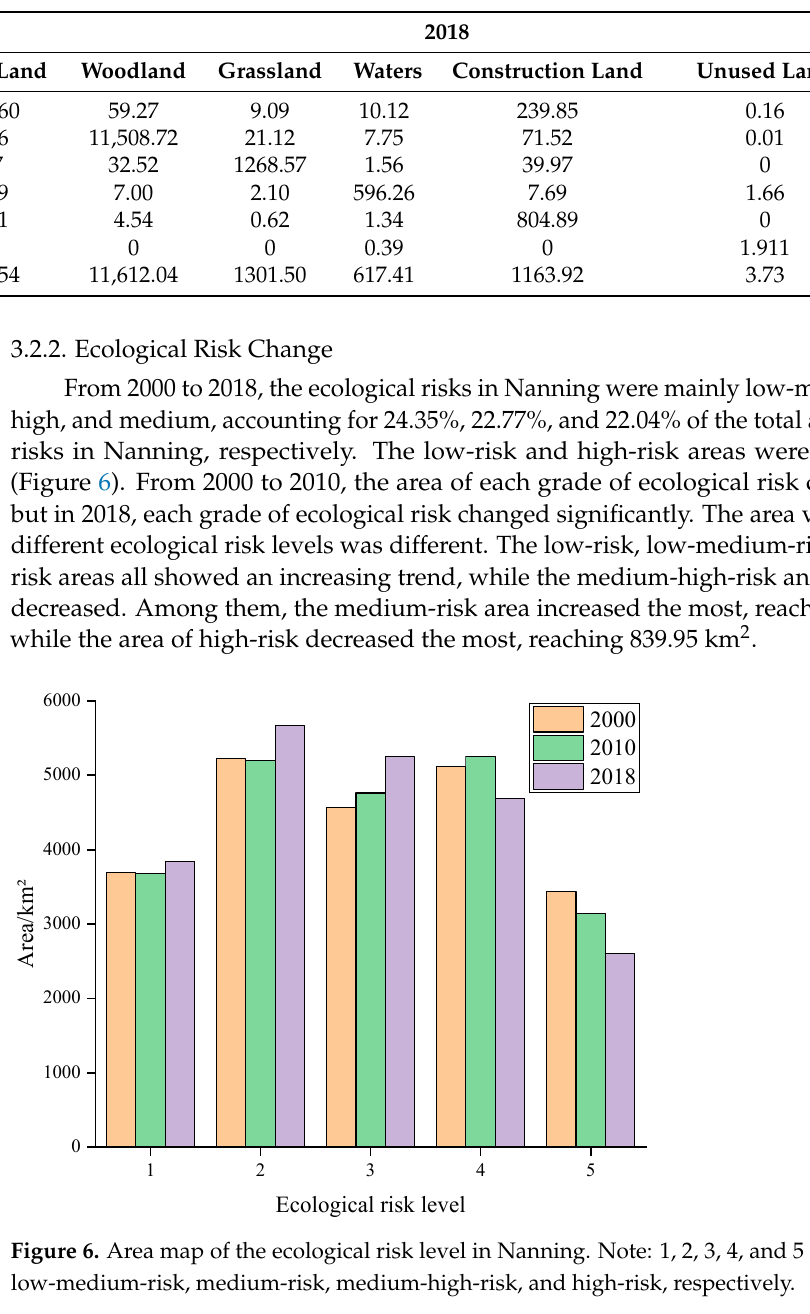
Table 4. Transfer matrix of LU types in Nanning from 2000 to 2018 (km 2 ).